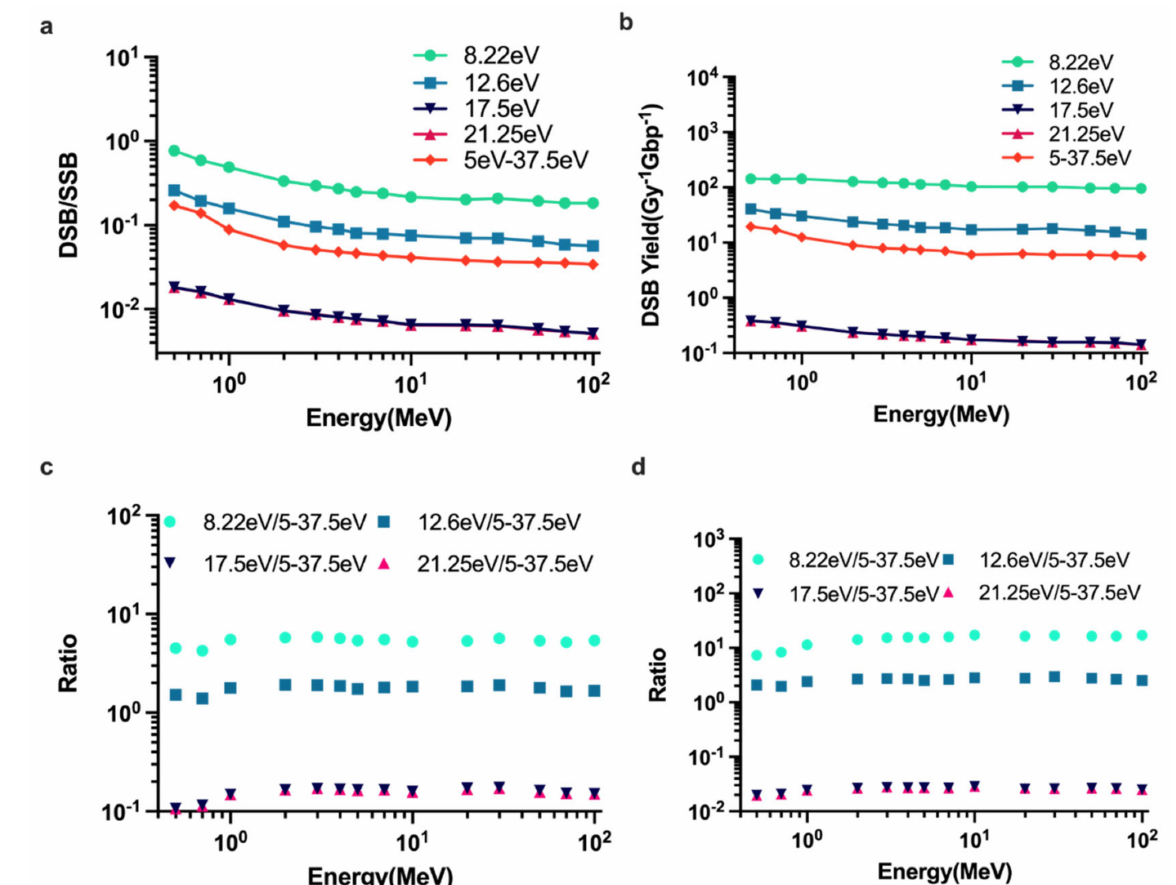
Figure 6. Comparison of DNA damage obtained with different energy threshold model for SSBs. All results were simulated with the opt2ELSEPA model. ( a ) The ratio of DSBs to SSBs with different ET models. ( b ) The total yields for DSBs with different ET models. ( c ) Ratio of constant ET model with linear proportional model of 5 − 37.5 eV for the DSB/SSB ratio. ( d ) Ratio of constant ET model with linear proportional model of 5 − 37.5 eV for DSB